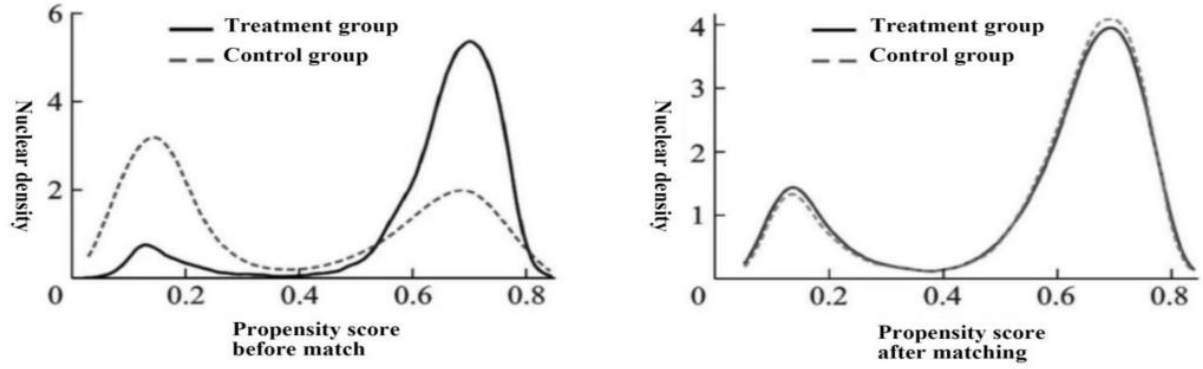
Figure 1. Comparison of tendency scores between the treatment group and control group pre- and post-PSM matching.